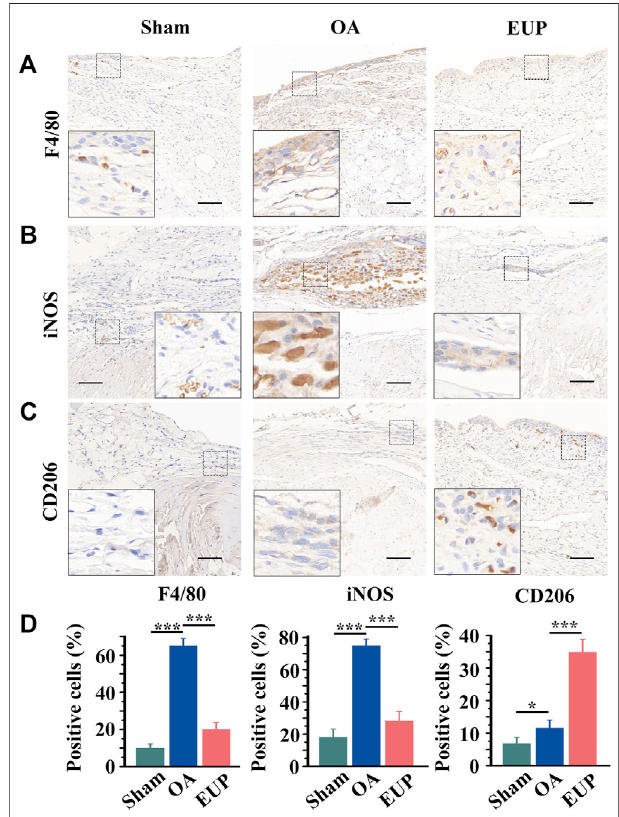
FIGURE 4 | Changes in the immunophenotype of macrophages in synovial tissue after EUP treatment. (A) immunohistochemistry of F4/80. (B) immunohistochemistry of iNOS. (C) immunohistochemistry of CD206. bar represents 100 μ m. (D) Quantitative detection of the proportion of F4/ 80, iNOS and CD206-positive macrophages in total macrophages. *, *** indicate statistically signi fi cant differences ( p < 0.05 and p < 0.001,